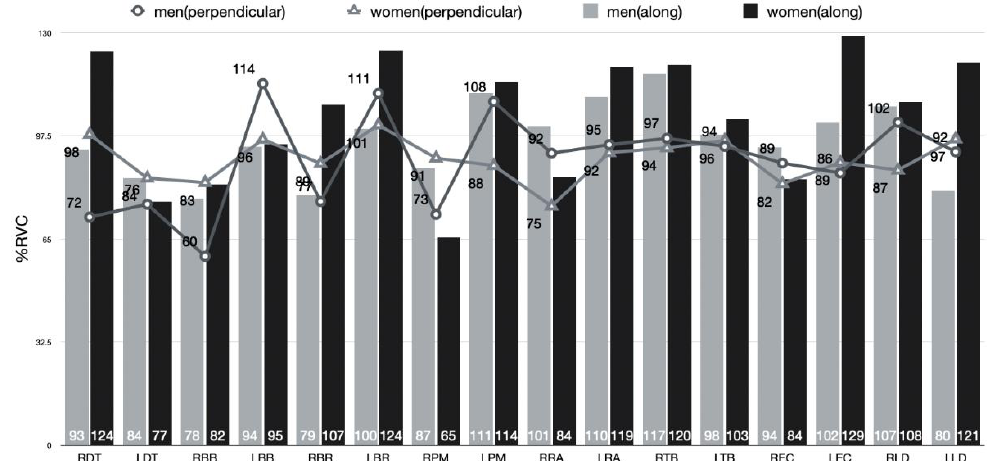
Figure 10. EMG in the pulling motion during sweeping (perpendicular to the axis of motion and along the axis of motion).